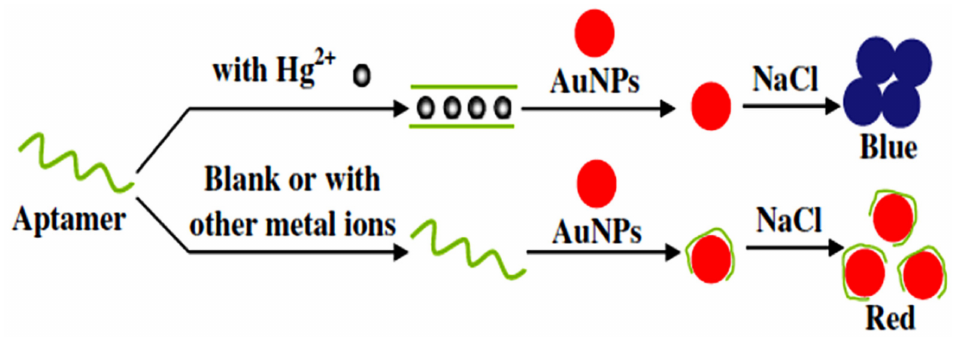
Figure 5. Schematic illustration of the AuNP colorimetric strategy for Hg 2+ detection [115]. Repro- duced with permission from Li et al., Anal. Bioanal. Chem. published by the Springer-Verlag 2009. AuNPs are also commonly used as a tracer in lateral flow strip (LFS). However, most